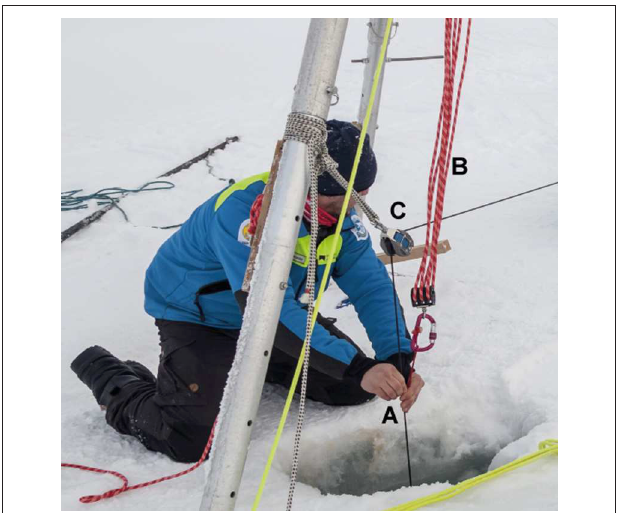
FIGURE 7 | Manual operation of the Klemheist friction knot (A) . Note the 6:1 backup pulley with red rope secured to the clamp on the tripod leg (B) and the attachment of the diversion block (C) to the tripod leg. Picture was taken during the training session, where a bigger tripod was used.